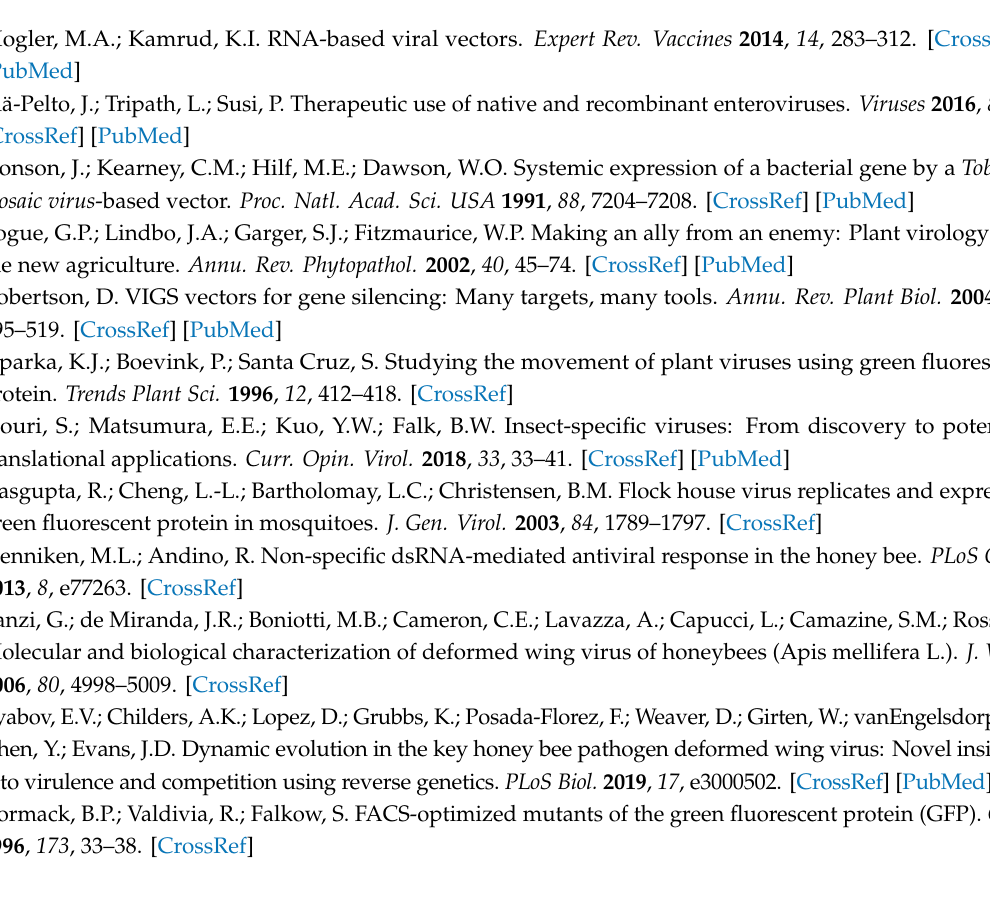
Figure S1: The eGFP-coding sequences inserts in DWV vector, Figure S2: Replication of the GFP-tagged DWV in honey bee pupae analyzed using a one-way ANOVA followed by a Tukey post-hoc test, Figure S3: Accumulation of the egfp deletant genomes in individual honey bee pupae, Table S1: Primers and the synthetic gene used in this study, Table S2: Quantification of DWV and GFP RNA targets in individual pupae, Table S3: Statistical significance of the di ff erences between DWV and GFP RNA copy numbers, Text S1. Design of pDWV-L-GPF and DWV-S-GFP, Text S2: Nucleotide sequences of the Deformed wing virus vector cDNA clones pDWV-L-GFP and